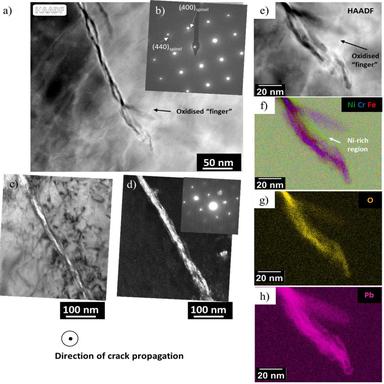
PbSCC crack termination generated in the caustic solution containing 5000 ppm PbO SCC test. (a) HAADF STEM image and (b) SADP from an area of the oxide filled crack showing the reflections obtained from the M3O4-type oxide. (c) BF and (d) corresponding CDF TEM images of the TG oxide-filled crack and corresponding SADP indicating the reflection used for the CDF image. (e) HAADF STEM image of the termination and elemental maps for (d) Ni Kα (green), Cr Kα (blue) and Fe Kα (red) combined, (e) O Kα (yellow) a